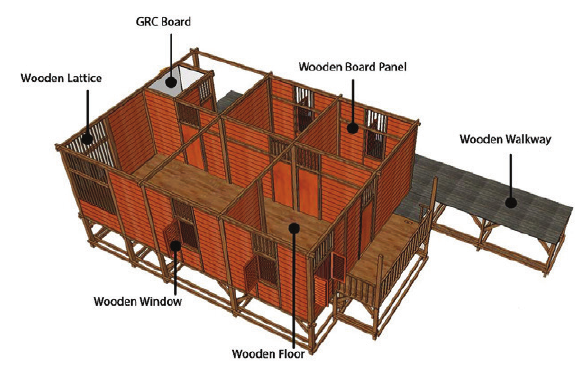
Figure 13. Building material